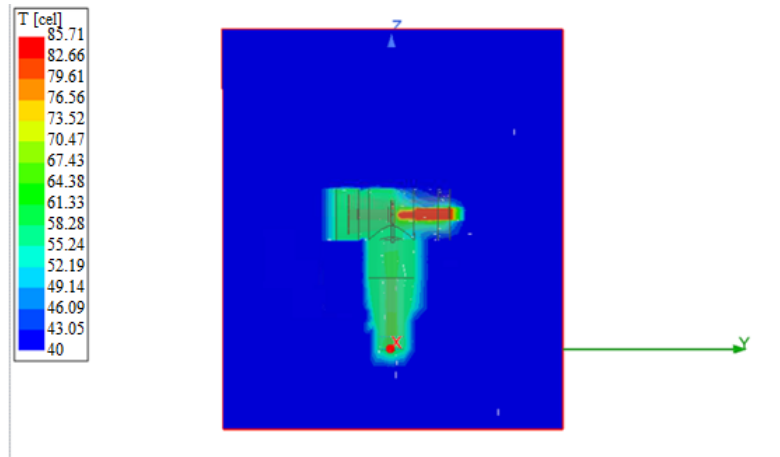
Figure 9. Temperature flow in a connector head, I = 630 A for an ambient temperature of 40 °C.